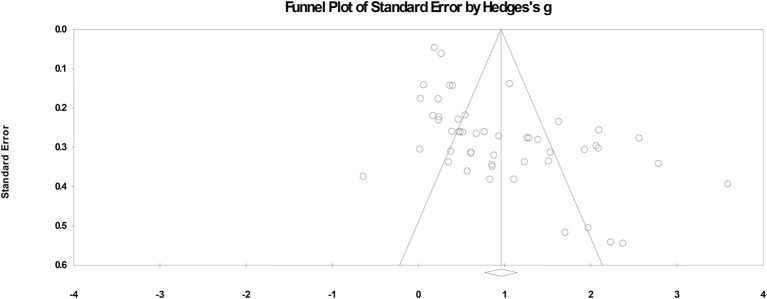
Funnel plot of 50 effect sizes (Hedges' g) generated from included studies to measure for publication bias.